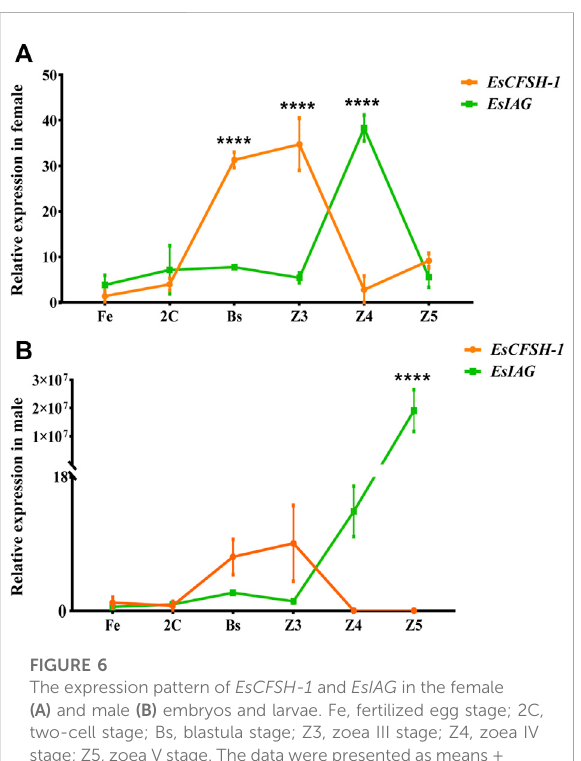
FIGURE 7 The expression relationships between EsCFSH-1 and EsIAG after gene knockdown in the eyestalk ganglion of female E. sinensis (A) Silencing ef fi ciency of EsCFSH-1 and the expression changes of EsIAG (B) Silencing ef fi ciency of EsIAG and the expression changes of EsCFSH-1 . EG- EsCFSH-1 , theexpressionof EsCFSH-1 in the female EG; EG- EsIAG , the expression of EsIAG in the female EG. The data were presented as means ± SEM of four separate individuals ( n = 4).Statistical signi fi cance was accepted at p < 0.05 and shown in different lower-case